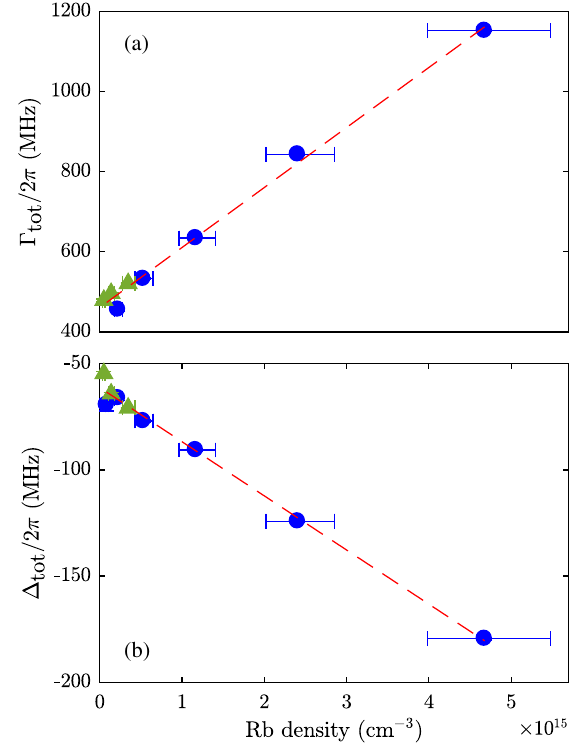
FIG. 6. Density-dependent measurements in the 50-nm slot waveguides. (a) Lorentzian linewidth for the l ¼ 30 μ m (blue circles) and l ¼ 200 μ m (green triangles) devices. (b) Corre- sponding line shift with linear